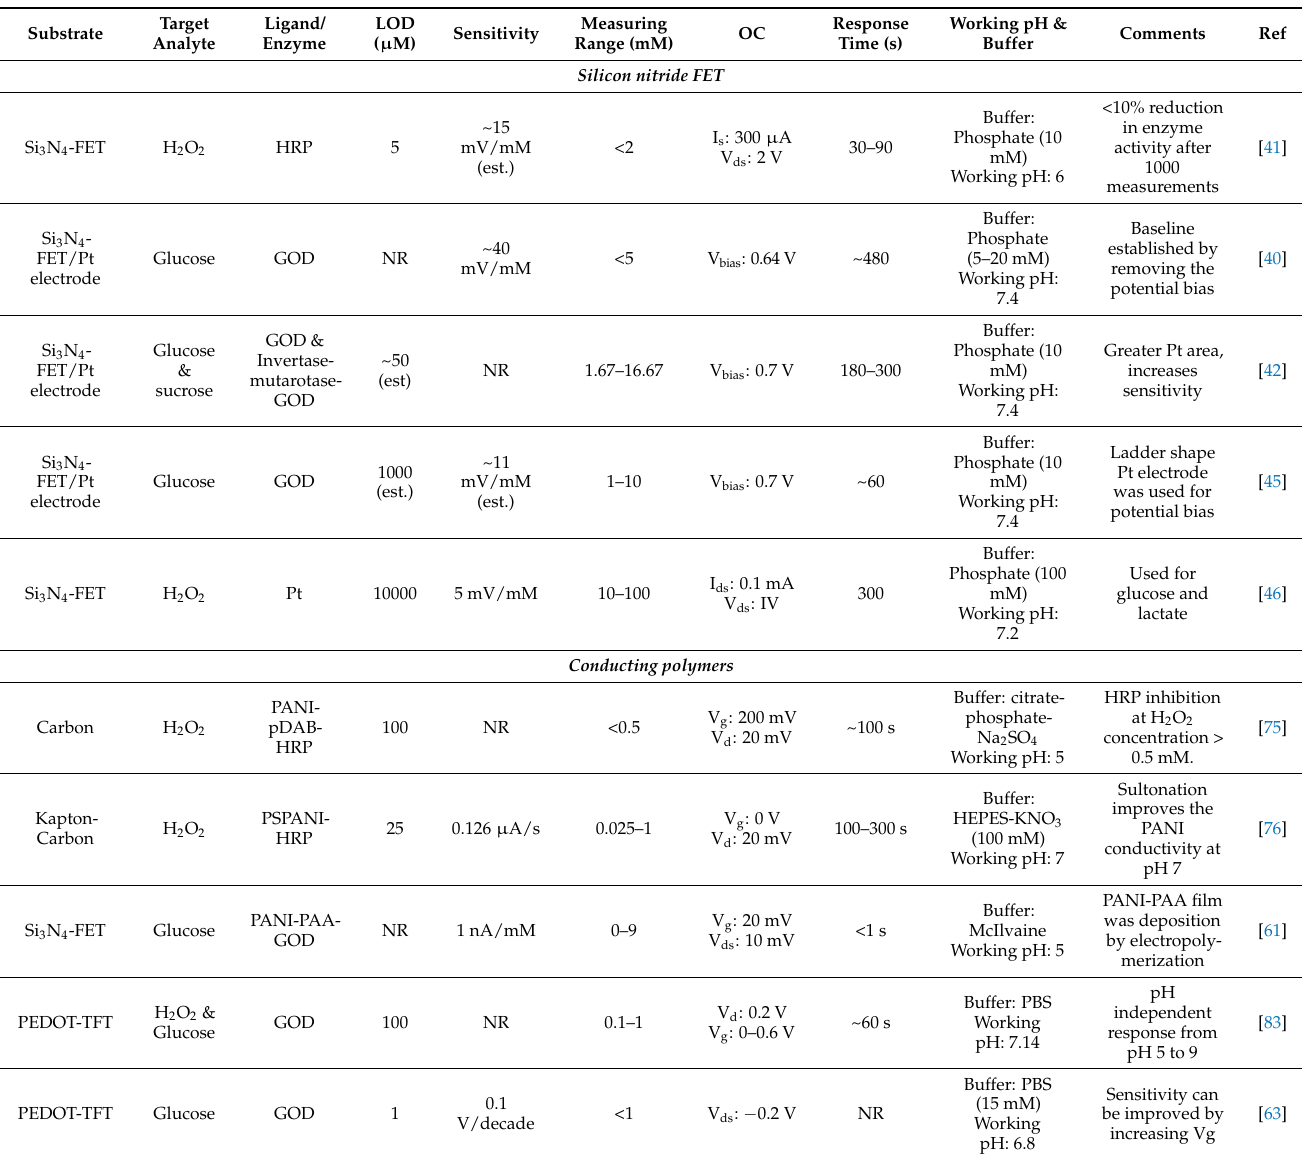
Table 3. Summary of various FETs used for H 2 O 2 measurement where OC: operating conditions; PANI: Polyaniline; PAA: poly acrylic acid; pDAB: poly(1,2 diaminobenzene); HRP: Horseradish peroxidase; PVP: poly(4-vinylpyridine-co-styrene); MOSC: Metal oxide semiconductor capacitor; 3-aminopropyltriethoxysilane (APTES), PPyNT: Polypyrrole nanotube, Pt: Platinum, I s : source current, V ds : Drain potential with respect to source, V g : is gate voltage, I ds : current between drain and source, V d : Drain potential, V bias : potential bias applied between the Pt electrode and reference electrode, I bias : current bias, pDAB: poly(1,2-diaminoben-zene), ITO: Indium titanium oxide, GluD: Glutamate dehydrogenase, UA: Uric acid,